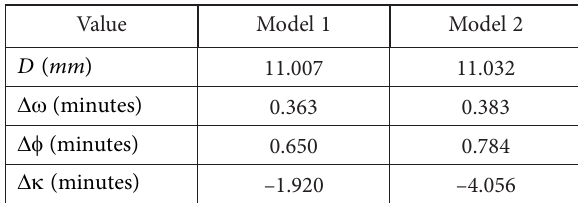
Table 4. Geometric relationship between extrinsic parameters